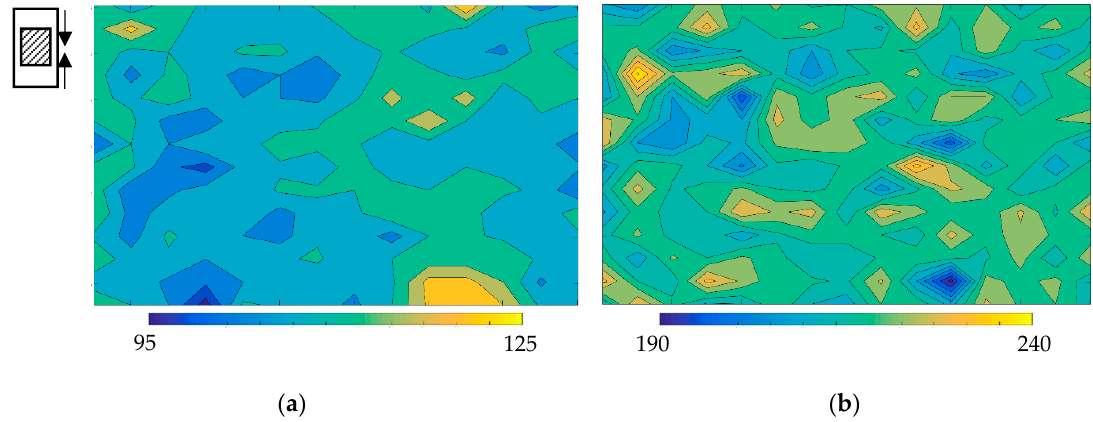
Figure 2. Microhardness mapping of Fe-30Ni material in ( a ) homogenized and ( b ) deformed to 0.3 strain at room temperature conditions, step size 0.5 mm. (Examination area 3.5 mm × 7 mm). Inset diagram: Arrows show the compression direction for the 15 mm height; 10 mm diameter samples and the shadowed region shows the examination area.